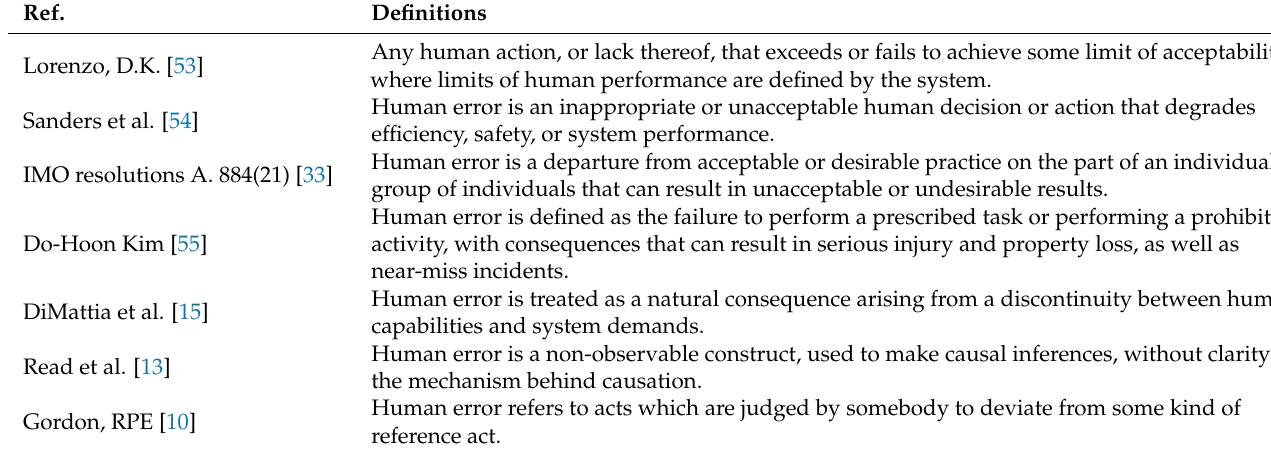
Table 4. Definitions of human error.